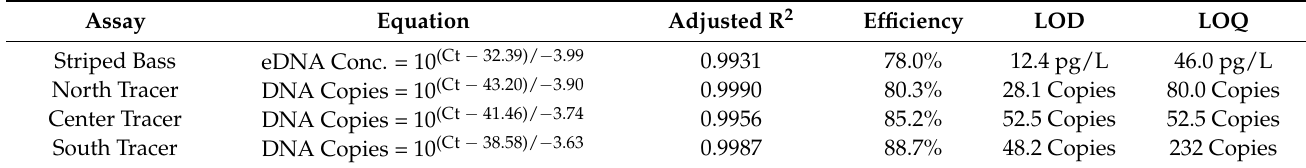
Table 2. Standard curve equations and associated adjusted R 2 , efficiency, LOD and LOQ for striped bass and artificial DNA tracer qPCR assays. LOD is the 95% limit of detection determined by probit modeling [50]. LOQ is the limit of quantification as determined by decay modeling, the lowest detectable concentration with coefficient of variance less than 35% [51]. LOD and LOQ units are pg of genomic DNA per L for the striped bass assay and DNA copies per qPCR reaction for the